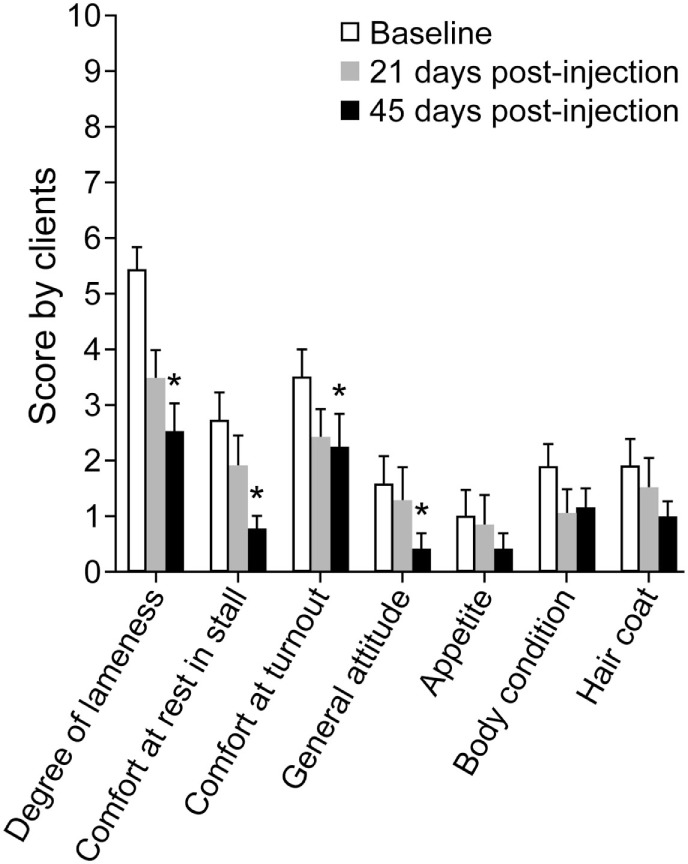
Graph of mean ± SEM client survey scores for assessment of lameness and discomfort before (Baseline), 21 days post-injection, and 45 days post-injection of dental pulp tissue particles. Client scores decreased across time (P < 0.001), significantly in four categories (lameness, comfort in stall, comfort in turnout, and general attitude) by day 45.